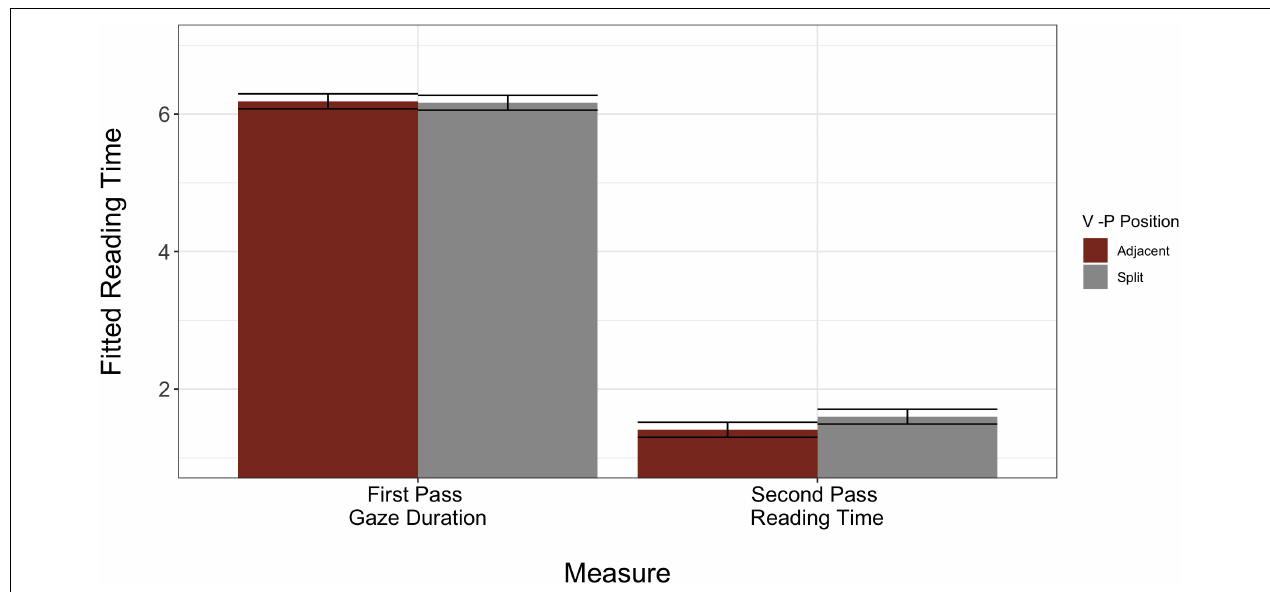
FIGURE 4 | Model fitted L2 reading times for core model interaction between reading measure × VP position. Error bars indicate plus/minus one standard error of the